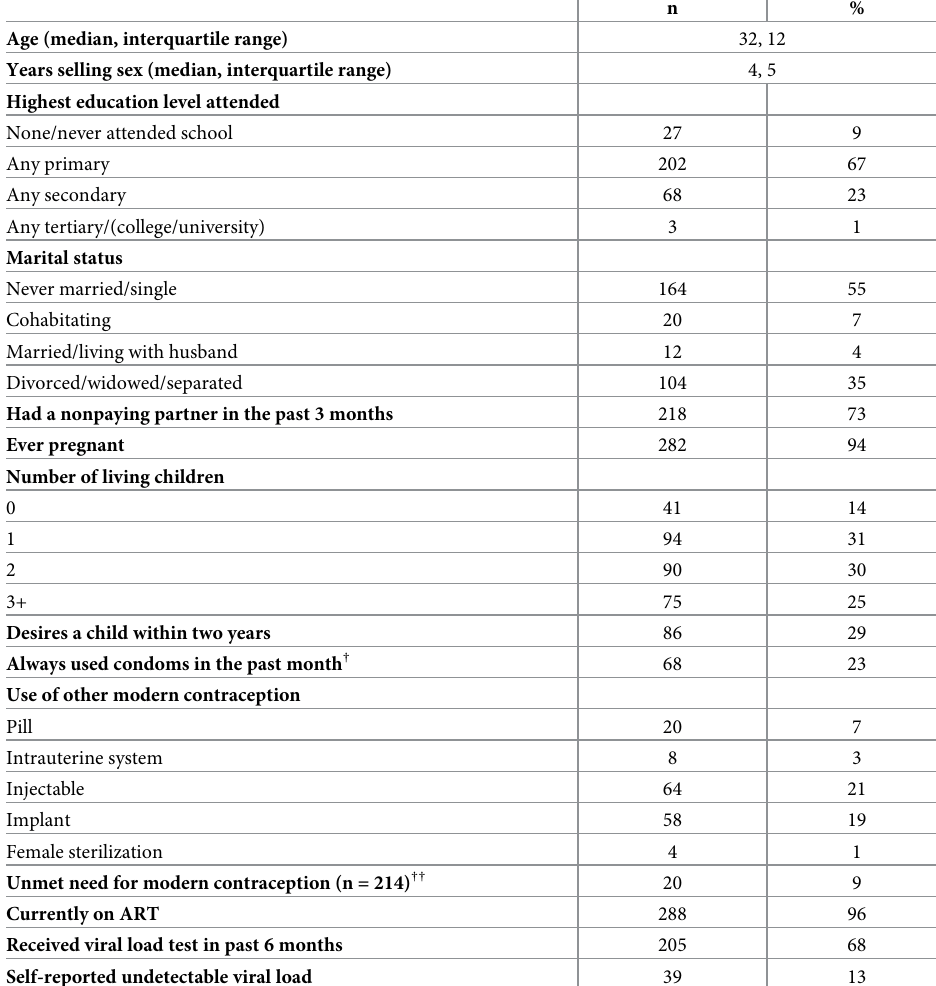
Table 1. Exit interview participant characteristics (N =